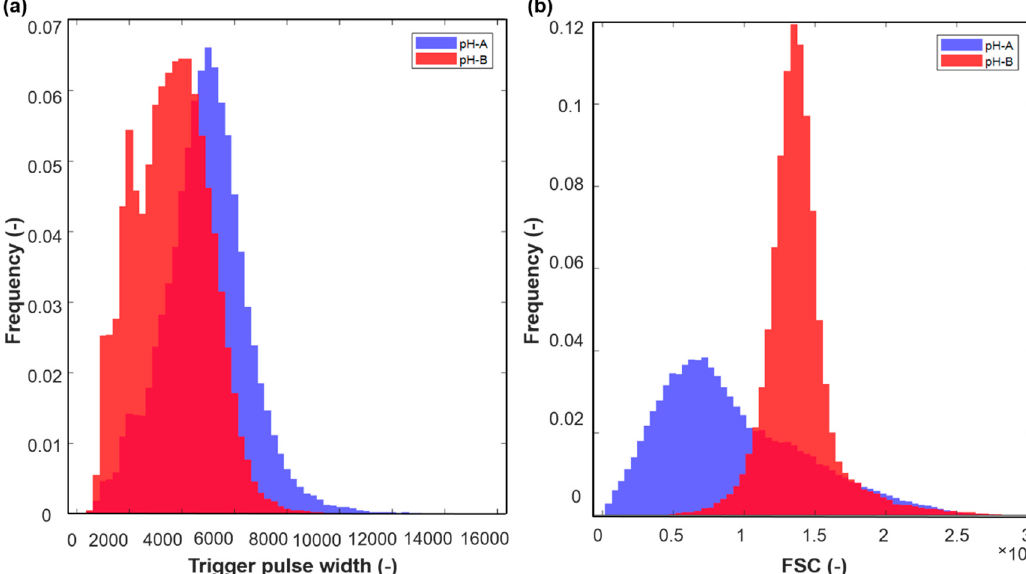
Figure 6. Normalized histograms of ( a ) flow cytometry trigger pulse width ( b ) forward scatter (FSC) signal for 10th hour samples taken from a representative pH-A and pH-B batch. Table 2. Statistical moments for flow cytometry (100,000 events) forward angle scatter/FSC (arbitrary units) and trigger pulse width (arbitrary units) of final-hour fermentation samples from pH-A and pH-B.